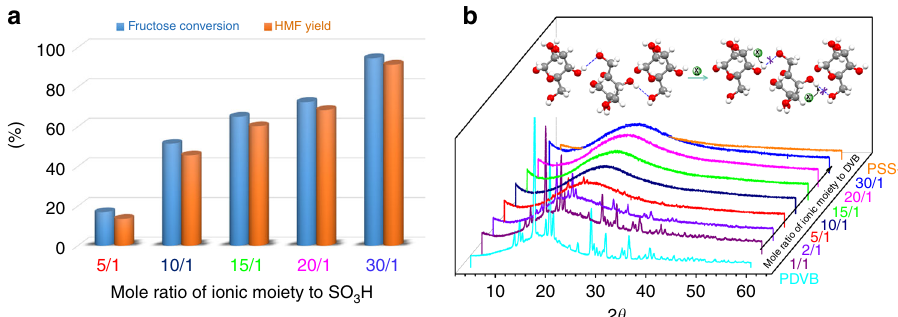
Fig. 3 The dependence of catalytic performance on the solvation ability of the catalysts. a The effect of mole ratio of ionic moieties to -SO 3 H groups on the catalytic performance of dehydration of fructose to form HMF. Reaction conditions: fructose (100 mg), catalyst (1.0 mol%), THF (5.0 mL), and 120 °C for 10 min. b XRD patterns of fi nely grinded polymers (PSS-xIL-DVB, x stands for the mole ratio of IL groups to divinylbenzene, 100 mg) and fructose (10 mg). Inset: schematic illustration of the interaction of the hydrogen bond acceptors, halide ions in ionic moieties, with the hydroxyl protons of the carbohydrates to break the extensive hydrogen bonding